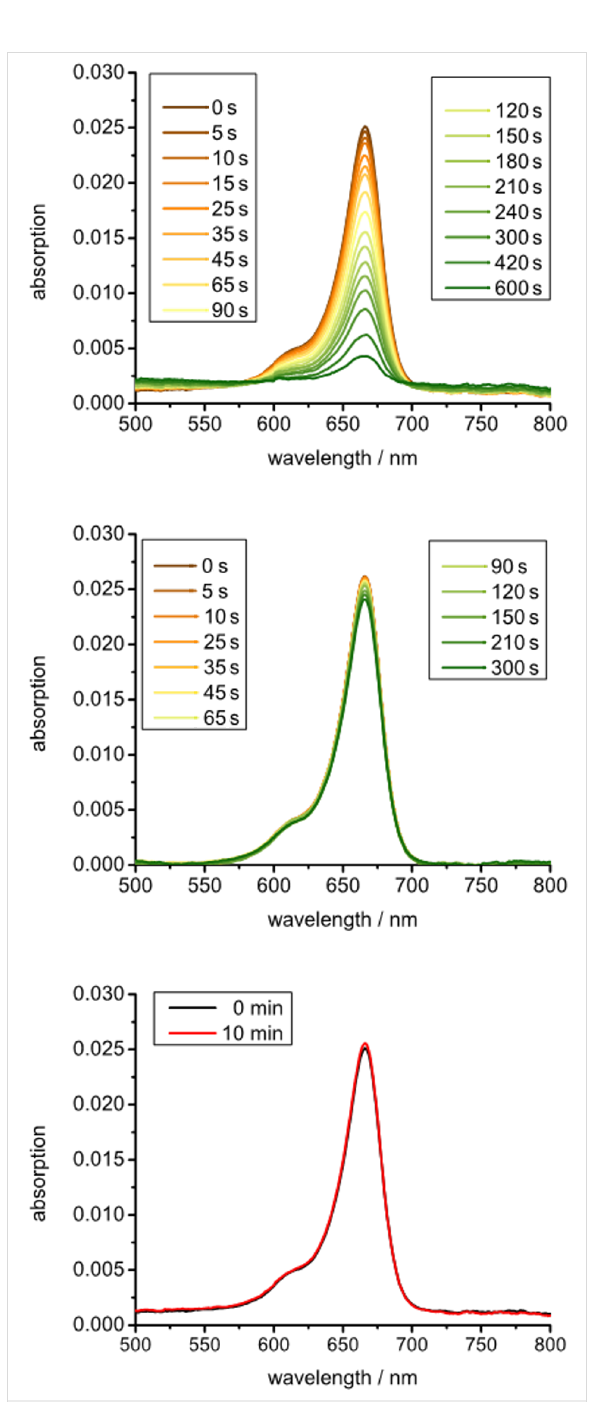
Figure 2: Absorption spectra of AdSq in acetonitrile. [AdSq] = 7.5 µM. Top: Absorption at different time points during irradiation. Middle: Absorption at different time points during irradiation of an argon equili- brated solution. Bottom: Absorption after and before storing in the dark for 10